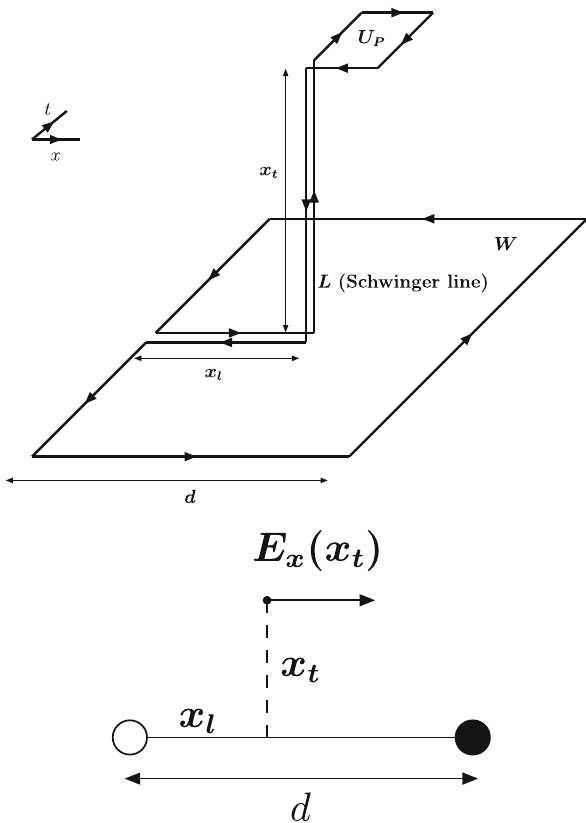
Fig. 1 The connected correlator between the plaquette U P and the Wilson loop (subtraction in ρ conn not explicitly drawn). The longitu- W ,μν dinal electric field E x ( x t ) relative to the position of the static sources (represented by the white and black circles), for a given value of the transverse distance x t ( x l = x , x t = y )